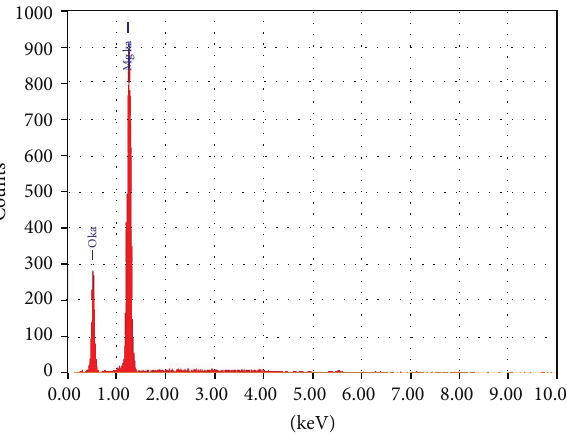
Figure 8: EDX spectrum of annealed MgO